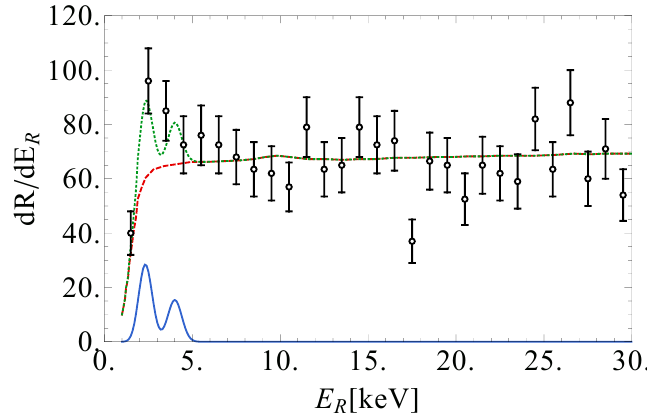
Figure 2 . Event rate for electron recoil as a function of recoil energy E R in keV. Blue line indicates the signal events from exothermic processes of dark mesons and green line shows the combined signal and background events. The red line is the background model used by Xenon experiment [1]. We have taken ∆ m = 4 . 0 keV and ¯ σ e /m χ = 1 . 2 × 10 − 43 cm 2 / GeV 1